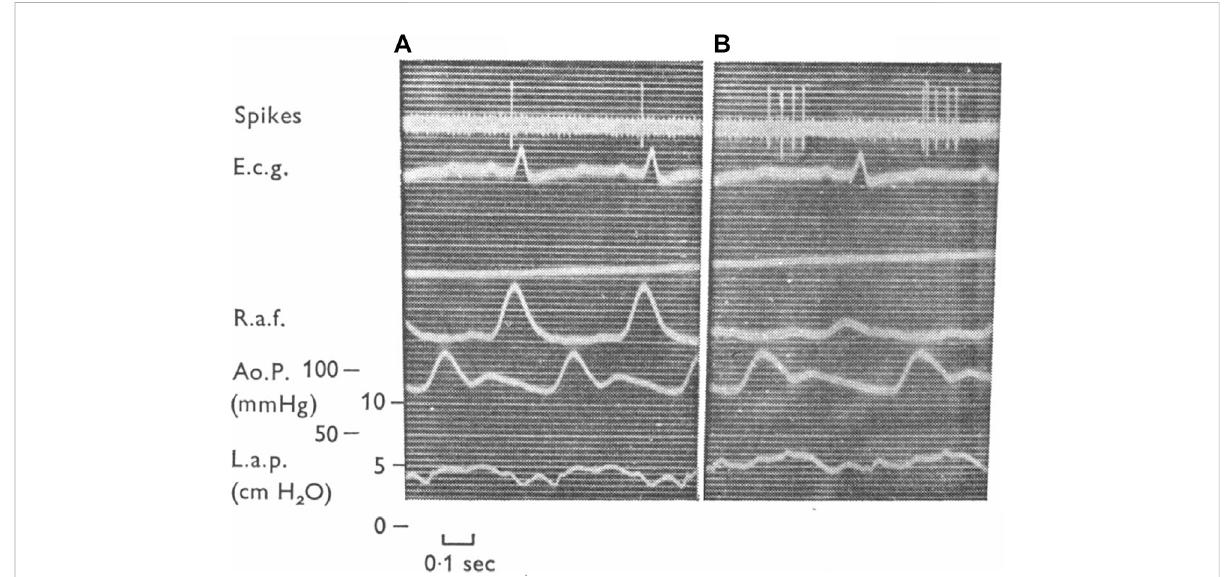
FIGURE 6 Aleftatrialunitbefore (A) andafter (B) administration ofpropranolol.Abbreviationsfromtopdownareunitactivity,EKG,rightatrialforce, aortic pressure and left atrial pressure. This unit exhibits type (A) activity during the control and type (B) following propranolol. In the opinion of these authors the receptors with (A) - and (B) -type fi ring constitute a rather homogeneous group of endings and their different discharge patterns are related mainly to their location in the atria. [Figure 12 (Gilmore and Zucker,